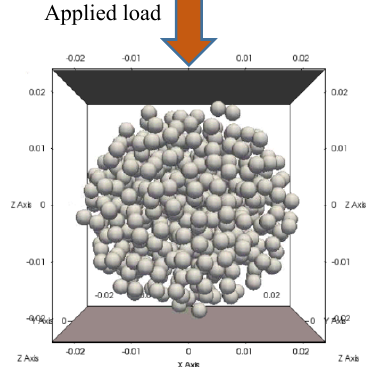
Fig. 1. Numerical specimen of agglomerate under compression (number of particles 448).